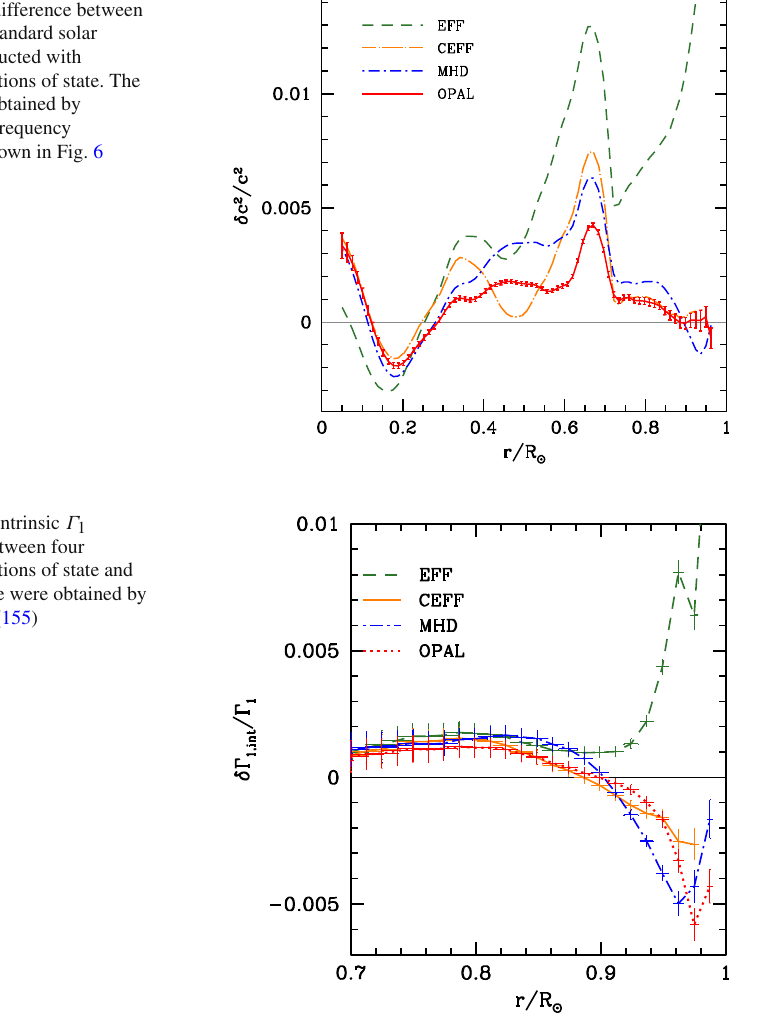
Fig. 21 The relative squared sound-speed difference between the Sun and standard solar models constructed with different equations of state. The results were obtained by inverting the frequency differences shown in Fig. 6